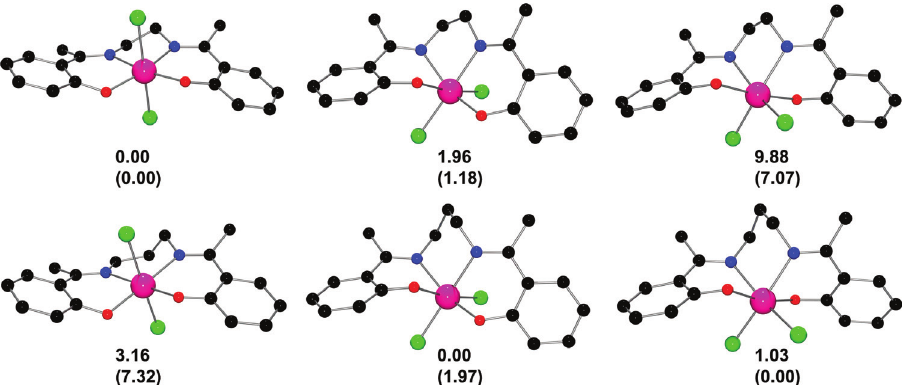
(top row) and L 2 SnCl (bottom row), 2 2